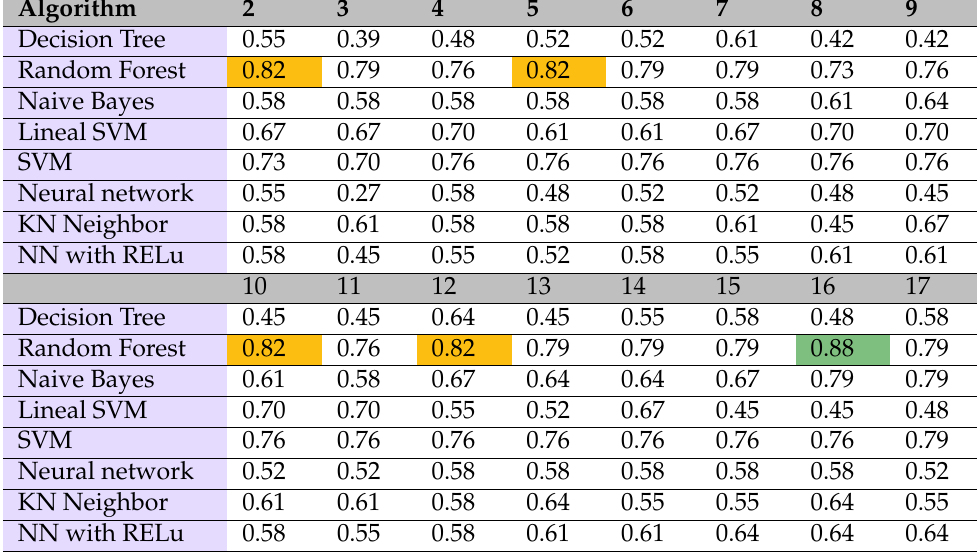
Table 2. Table of accuracy with chi-squared without height and weight.